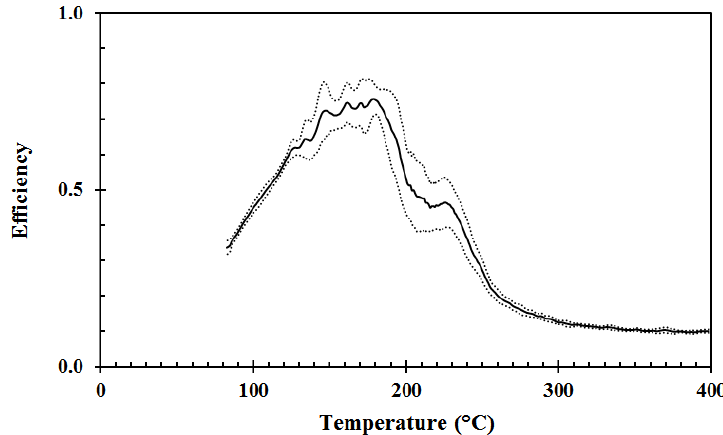
Figure 8. Average cooling efficiency for water droplets impinging onto the stainless steel disc with a surface roughness of Ra 0.4 as a function of temperature ( black ). The dotted lines represent ± one standard deviation, respectively.